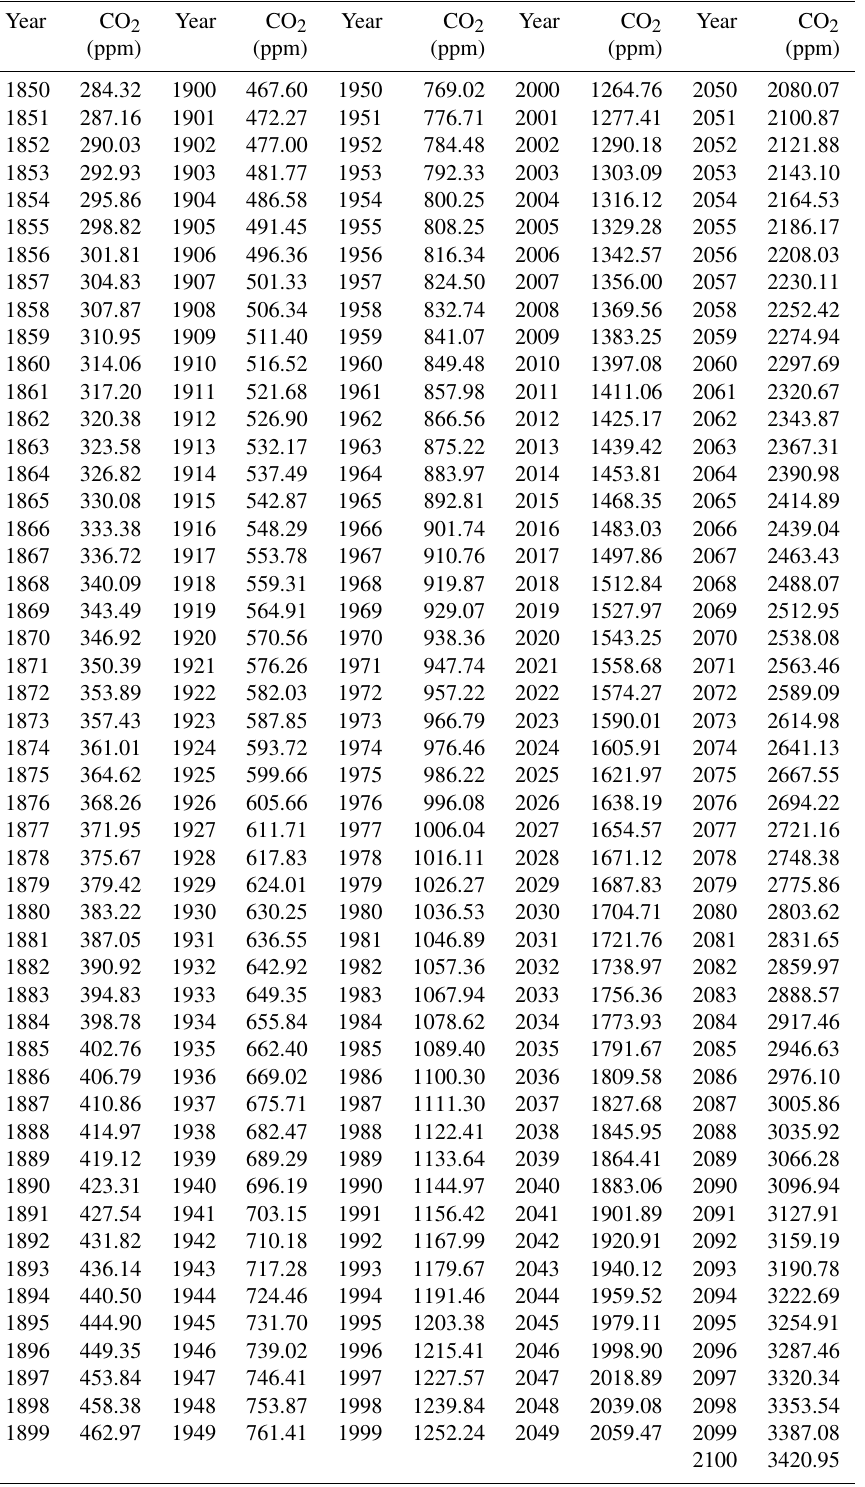
Table 9. 1pctCO2: global-mean annual-mean surface CO 2 concentrations for idealized CMIP6 experiments 1pctCO2. All other gases, as in picontrol run (see Table 8). The value 284.317ppm with three-digit precision in year 1850 is increased by 1% per